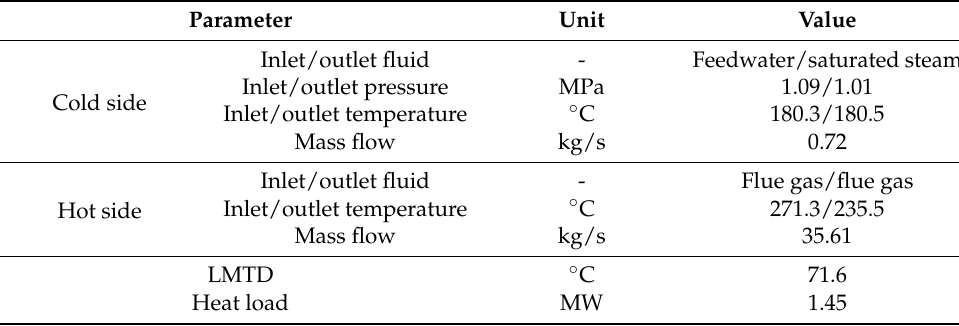
Table 10. Parameters of the AE in the integrated design.